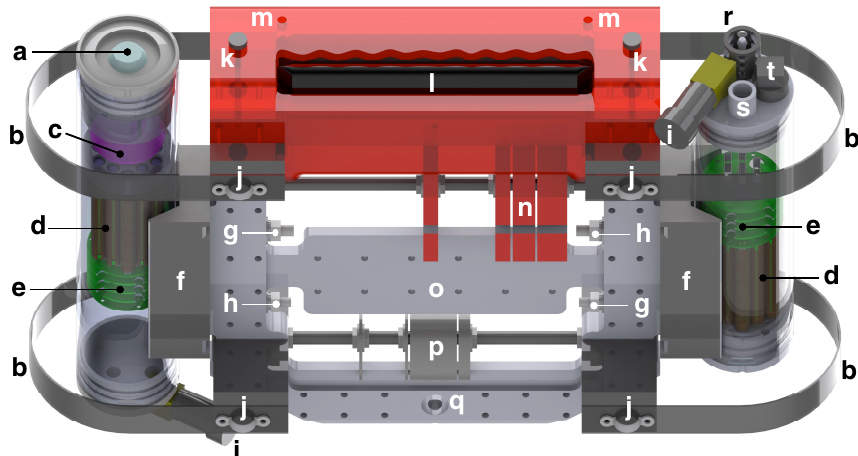
Fig. 3. A transparent drawing of the C-OPS in-water instrument showing the following components (the roll axis is along the long axis of the instrument and the pitch axis is along the short axis, which is into or out of the page): (a) the cosine collector for the irradiance sensor; (b) the bumpers , which protect the light sensors from side impacts during deployment and recovery; (c) the irradiance lens, which uniformly spreads the diffuse light from the cosine collector out across the array of microradiometer apertures below the lens; (d) the cluster of 19 microradiometers; (e) the aggregator and support electronics boards, which allow the microradiometers to be controlled as a single device; (f) the sensor v-blocks, which are attached to the backplane at a fixed point and a rotation point; (g) the fixed point nuts; (h) the pitch adjustment nuts, which when loosened allow an offset bias of the sensor to be set to counter cable tension or an ambient current that can pitch the instrument away from the desired vertical tilt of less than 5 ◦ ; (i) the dummy plugs attached to the sensor bulkhead connectors (cabling not shown for clarity); (j) the harness attachment points (harness not shown for clarity); (k) the knurled screws that hold the lid on the hydrobaric buoyancy chamber, which can contain a mix of up to three compressible bladders and rigid foam inserts; (l) the hydrobaric buoyancy chamber revealed with the use of a cutaway section to have two air-filled bladders, which slowly compress and allow the instrument to loiter near the sea surface; (m) the air holes that allow the hydrobaric buoyancy chamber to flood (two of four shown); (n) the foam flotation disks, which can be moved from side to side to trim the roll axis of the instrument to maintain a desired vertical tilt of less than 5 ◦ (the slotted edge is visible as the dark band below the letter “n” for clarity, but is normally oriented downwards and then held tightly by the nuts to the left and right of the disks); (o) the perforated backplane (the holes allow for securing the cabling and the mounting of other devices); (p) the weight disks, which like the flotation disks are slotted and firmly affixed using nuts to the left and right, establish the negative buoyancy and can be moved from side to side to trim the roll axis of the instrument; (q) the fitting point for a flexible or rigid downward-pointing spar, which if used can provide protection against a bottom impact; (r) the water temperature probe; (s) the pressure transducer port; and (t) the nitrogen purge fitting (one on each